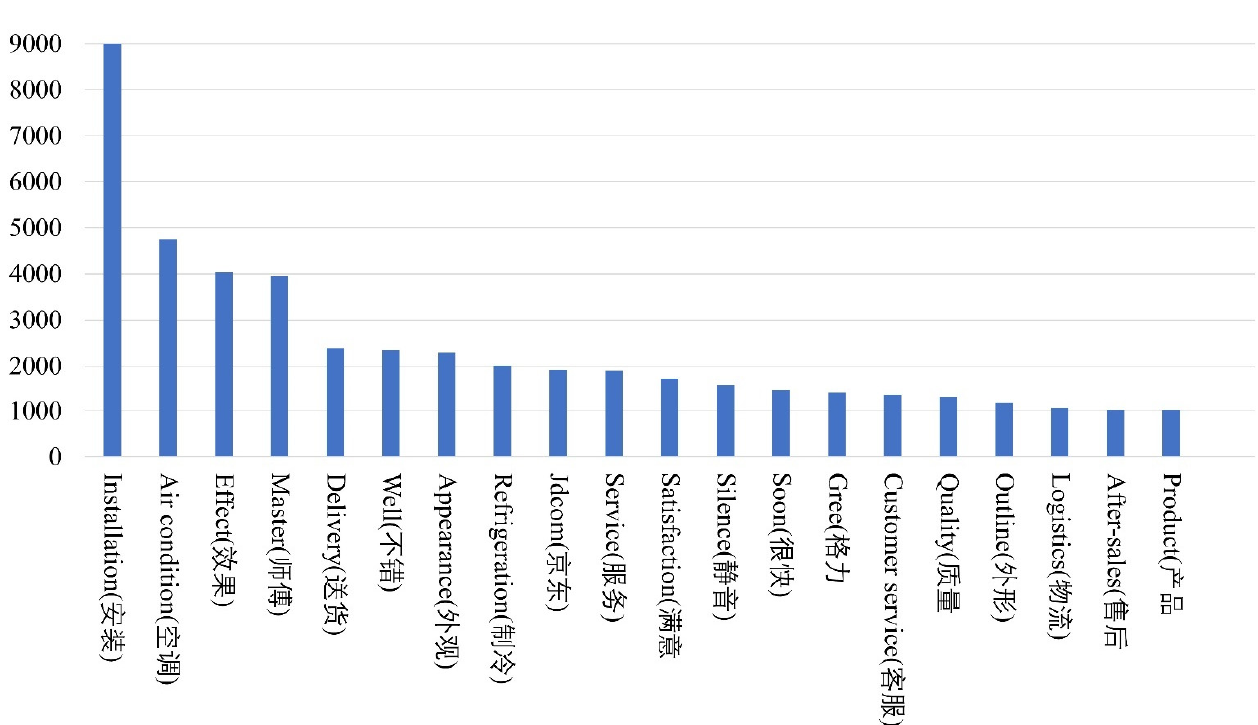
Figure 8. Word frequency diagram.